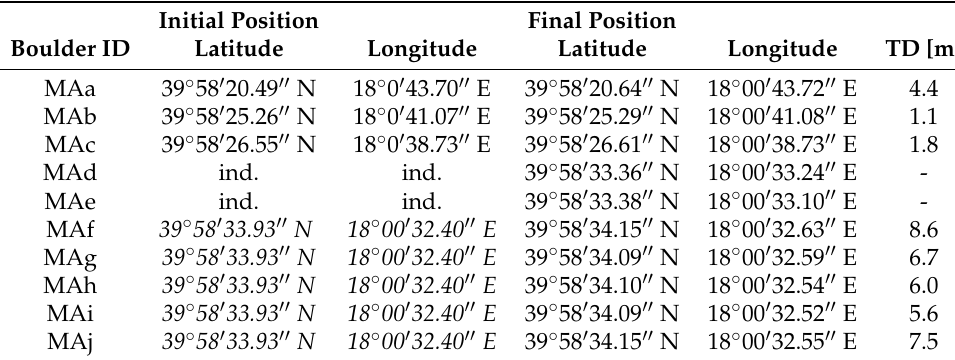
Table A7. Initial and final geographical coordinates of the displaced boulders at the Mancaversa coast; ind., indeterminable. Initial Position Final Position Boulder